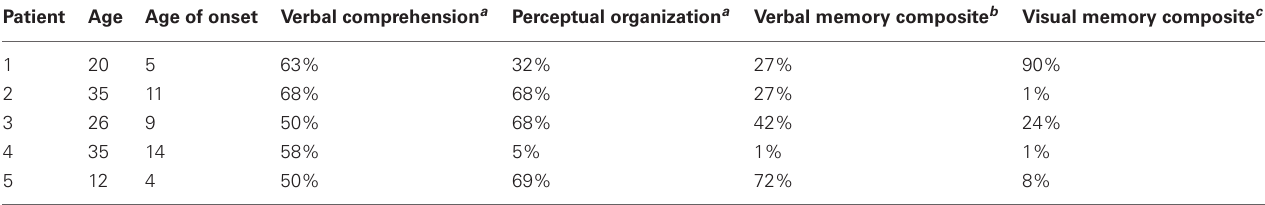
Table 1 | Patients demographics and performance during pre-operative neuropsychological